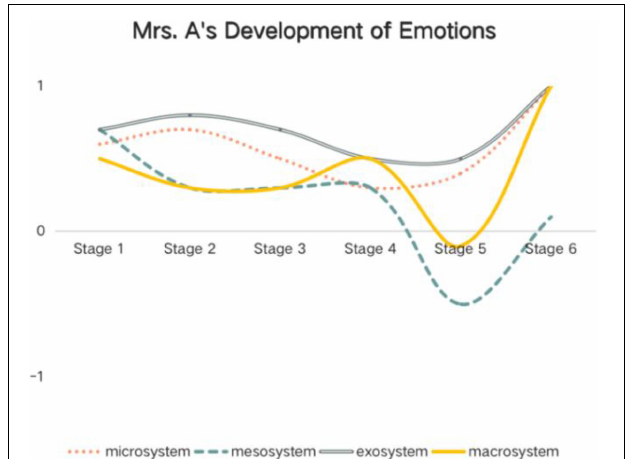
FIGURE 2 | Mrs. A’s development of emotions within different ecological system.